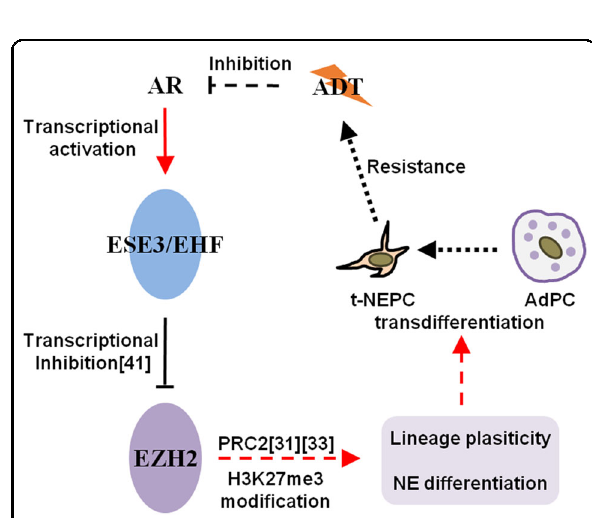
Fig. 7 Proposed model of EHF loss-mediated therapeutic resistance and NE differentiation of prostate cancer. AR androgen receptor, ADT androgen deprivation therapy, PRC2 polycomb repressive complex 2, t-NEPC treatment-induced neuroendocrine prostate cancer, AdPC prostate adenocarcinoma, NE